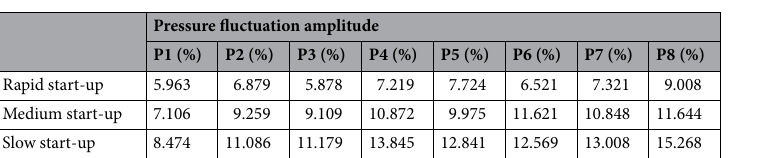
Table 3. Pressure fluctuations at different monitoring points of the